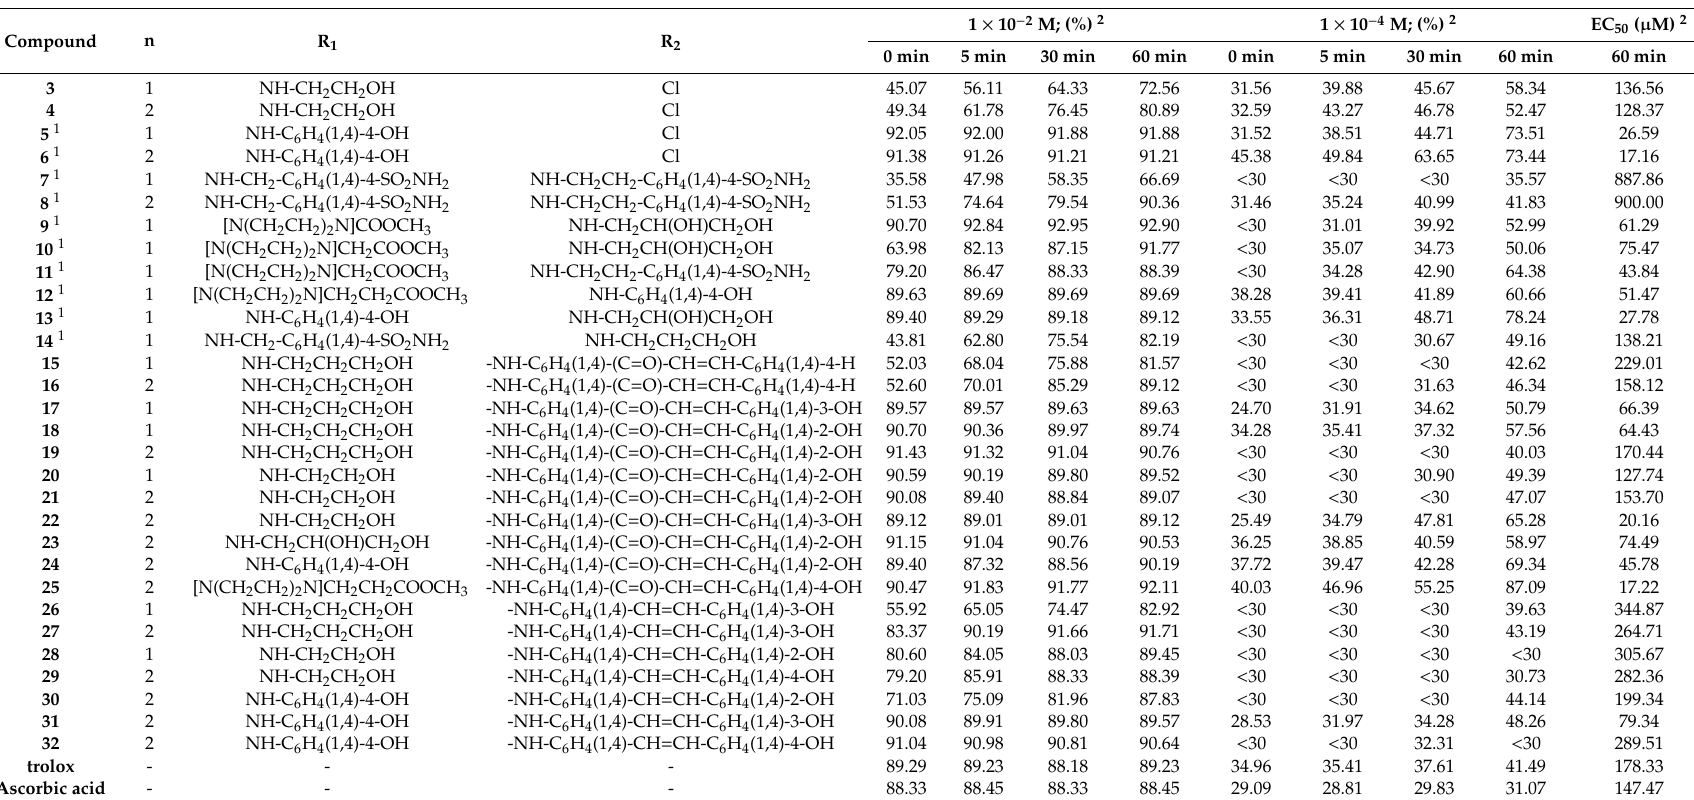
Table 1. ABTS cation radical scavenging ability of tested compounds expressed as %inhibition at di ff erent times (0, 5, 30, and 60 min) and di ff erent